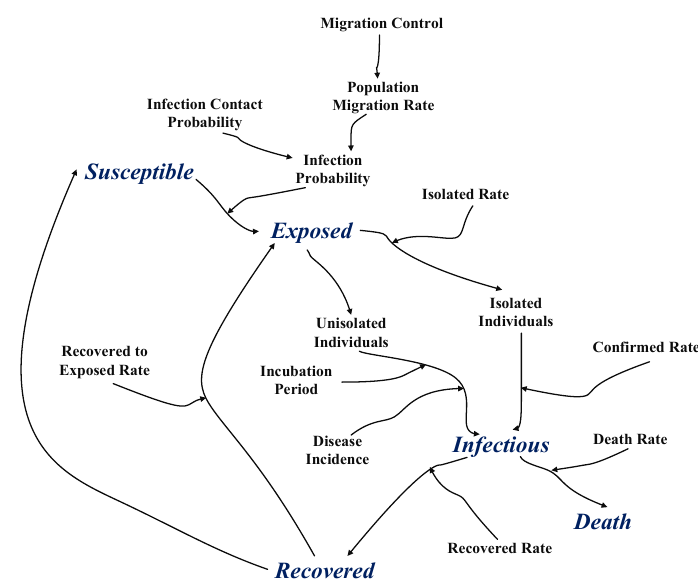
Figure 3. Dynamic causality diagram for the extended SEIR-SD model.